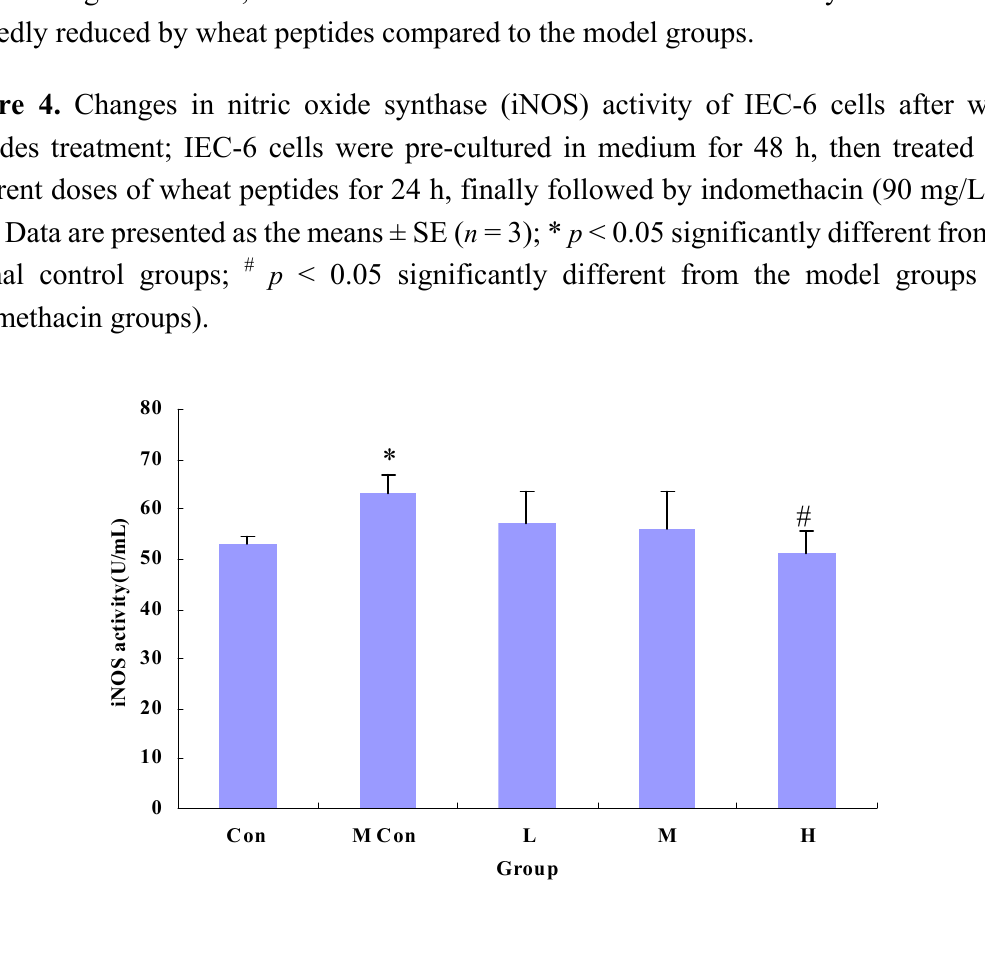
Figure 5. Changes in NO concentration of IEC-6 cells after wheat peptides treatment; IEC-6 cells were pre-cultured in medium for 48 h, then treated with different doses of wheat peptides for 24 h, finally followed by indomethacin (90 mg/L) for 12 h. Data are presented as the means ± SE ( n = 3); * p < 0.05 significantly different from the normal control groups; # p < 0.05 significantly different from the model groups (the indomethacin